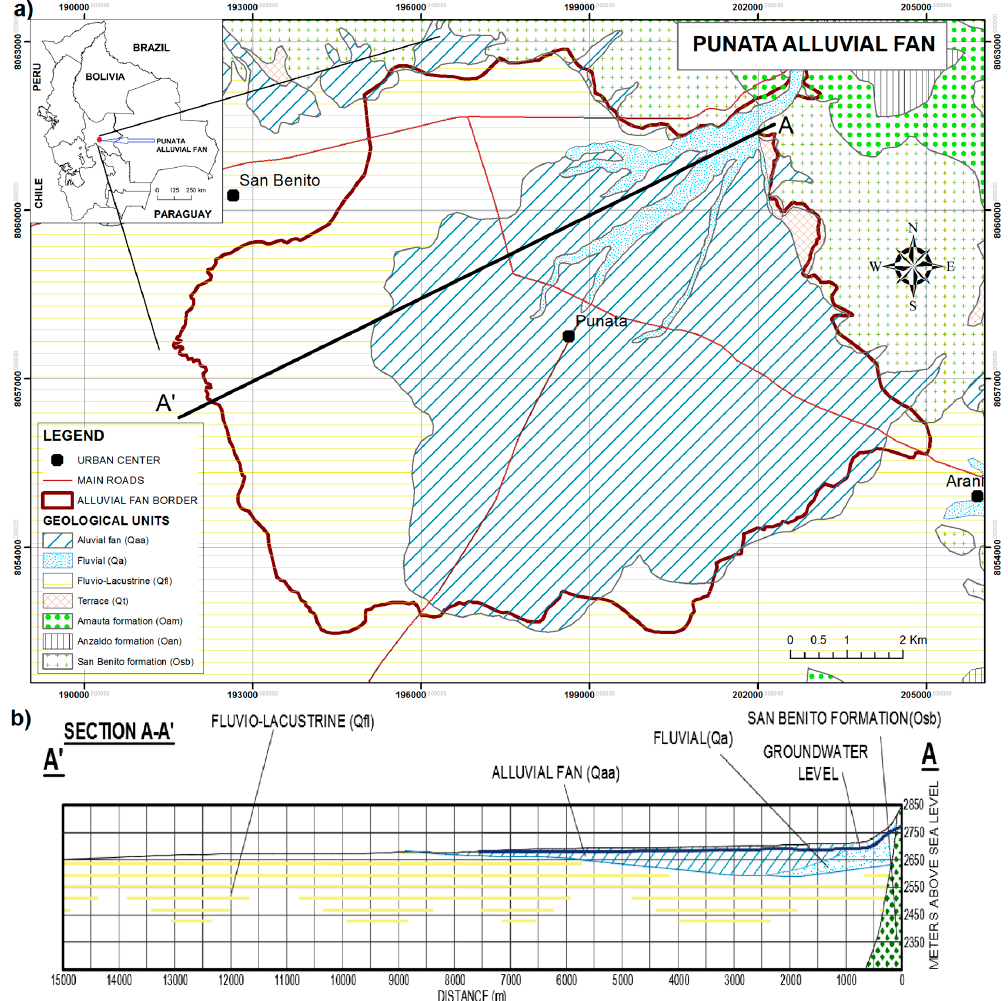
Figure 1. ( a ) Location of the study area in the central part of Bolivia and regional geology overview, modified from SERGEOMIN [28]; ( b ) Cross section of the study area, from UNDP-GEOBOL [26].